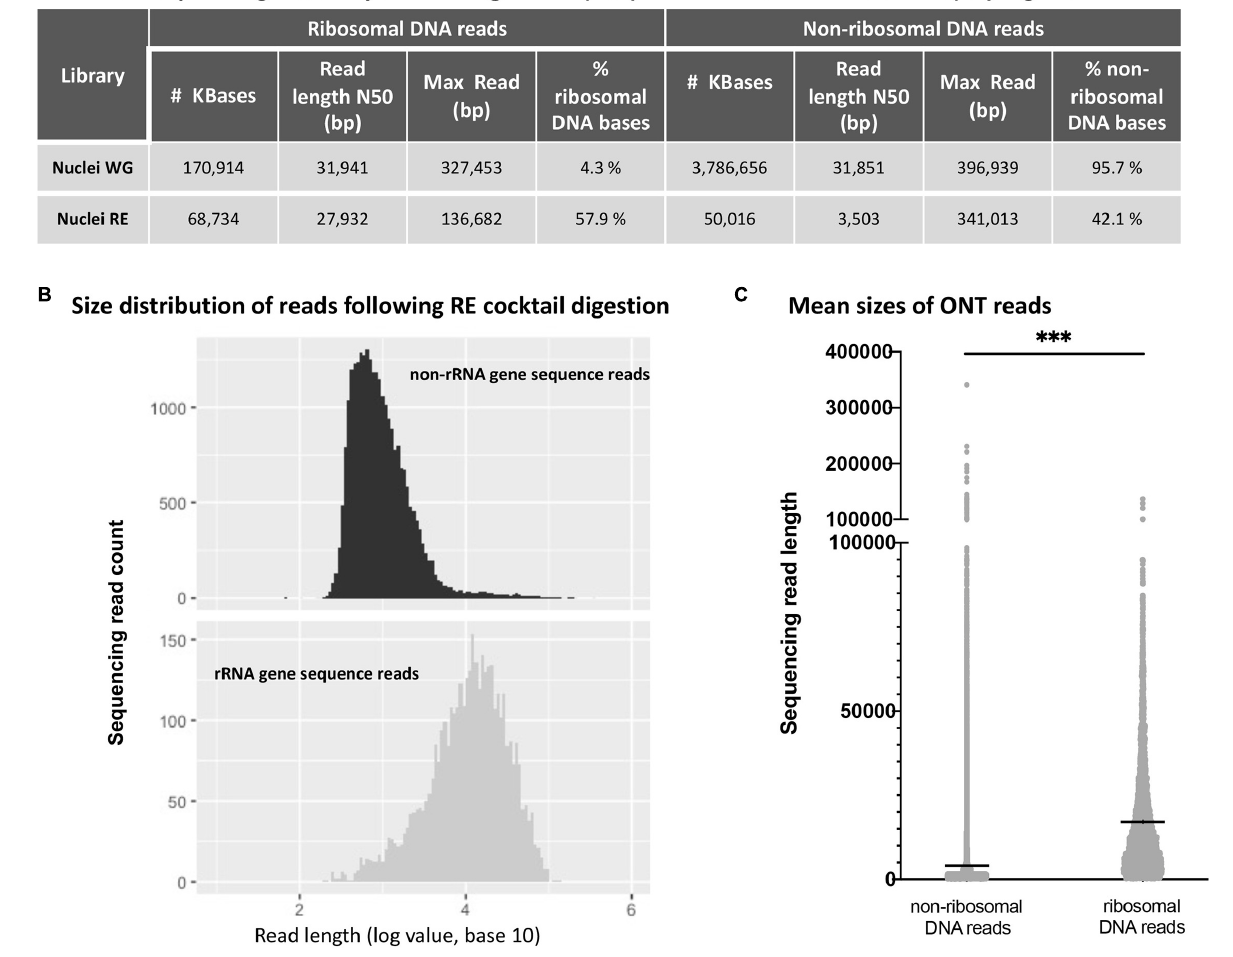
FIGURE 3 | Oxford Nanopore sequencing results for whole genome (WG) vs. restriction endonuclease (RE)-digested DNA. (A) Effect of restriction endonuclease cocktail digestion on read distribution for non-ribosomal and ribosomal RNA gene sequences. (B) Non-ribosomal DNA (top) and ribosomal RNA gene DNA (bottom) read numbers are plotted as a function of read length. (C) Sequencing read mean length (horizontal black lines within the distributions) for non-ribosomal and ribosomal RNA gene sequences are significantly different (*** denotes unpaired t -test values of p <